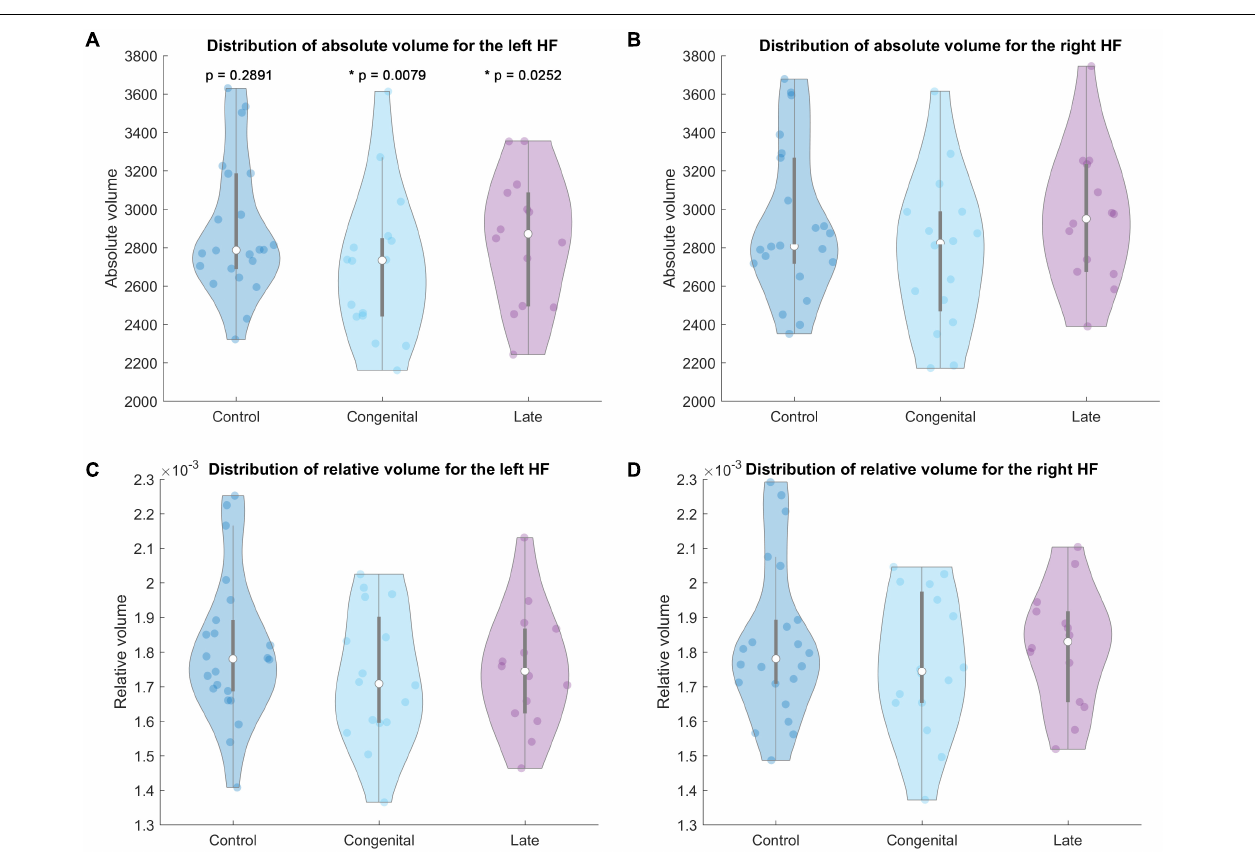
FIGURE 2 | Violin plot of the hippocampal volumes for each group. Top row absolute volume of the left (A) and right (B) HF. Bottom row relative volume of the left (C) and right (D) HF. P values in the top left A part mean the hemispheric difference of the absolute volumes for each group, p < 0.05 labeled with * as statistically